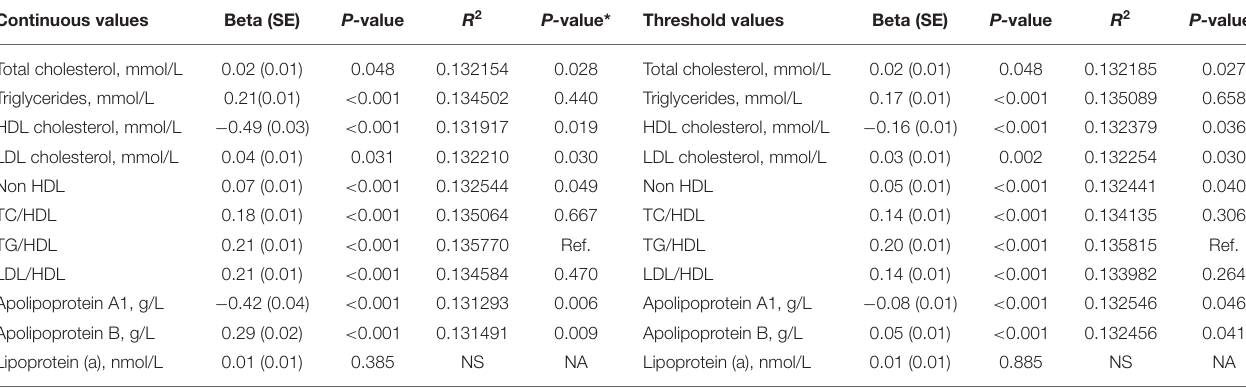
TABLE 5 | Multiple linear regression models for continuous ASI values with each lipid parameter in continuous values and in threshold cutoffs. Continuous values Total cholesterol, mmol/L